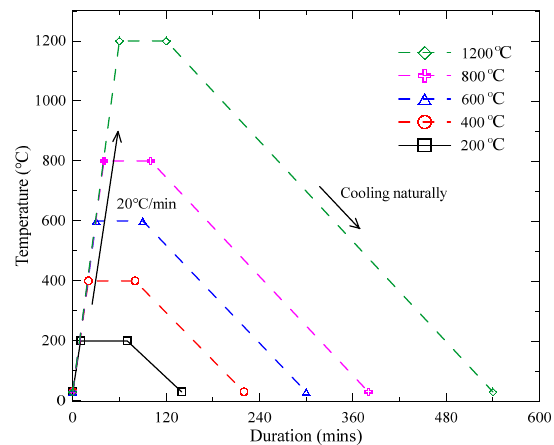
Figure 6. Heating regimes of various target temperatures.